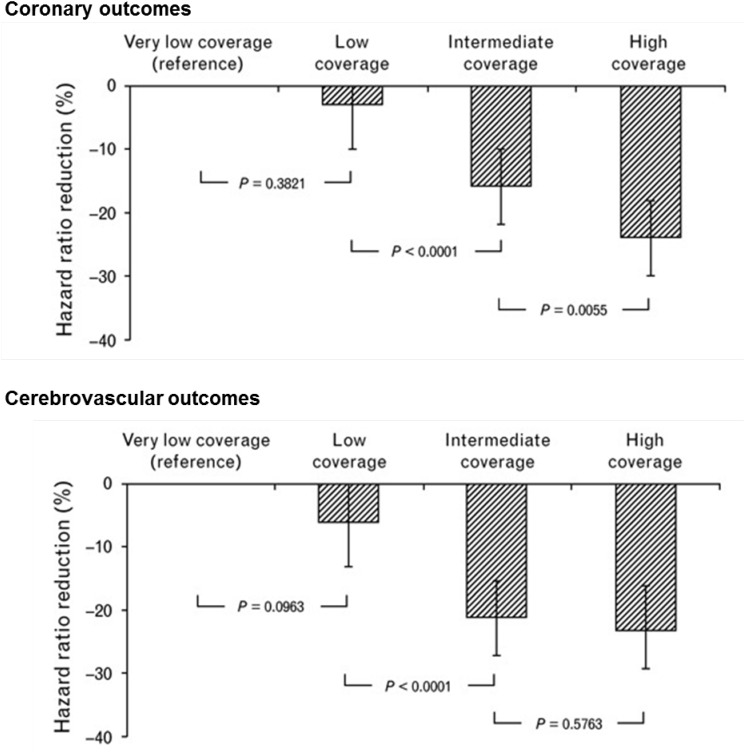
Dose-dependent effect of adherence with antihypertensive drug therapy on the reduction in hazard ratio of coronary and cerebrovascular outcomes. Analysis of the Lombardy database. Adherence measured according to the proportion of days of observation covered by antihypertensive medication. Adherence levels are the following: very low coverage: <25%; low coverage: 26–50%; intermediate coverage: 51–75%; and high coverage: >75%. Adapted from Corrao et al. (2011).